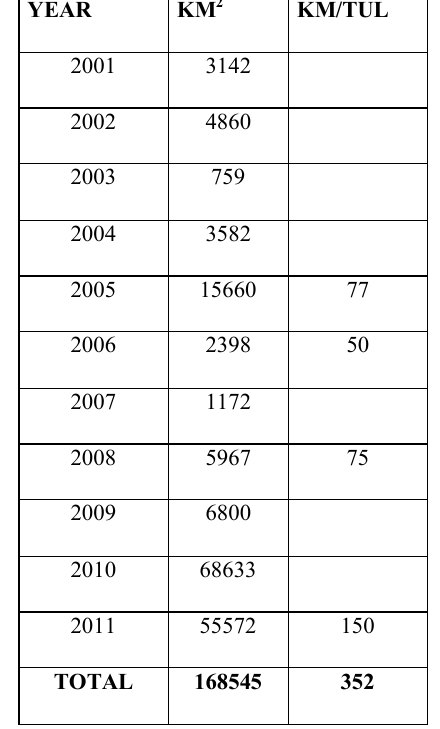
Table 1: The quantity of aerial photography acquisition in the last